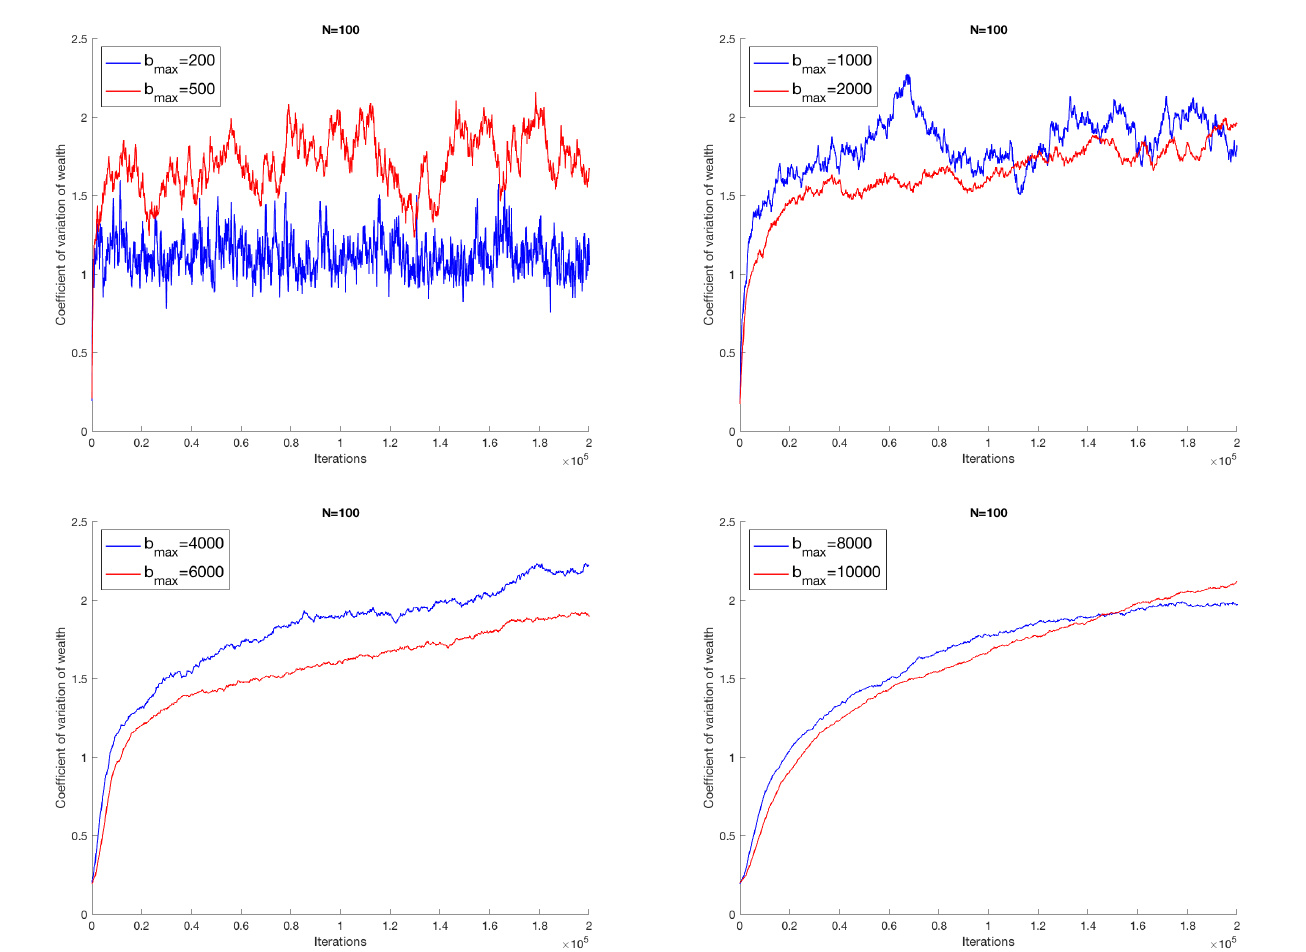
Figure 2. Plot of the coefficient of variation of the amount of money of the economic agents as transactions go on for N = 100 and b max = 200,500 ( top left) , b max = 1000,2000 ( top right ), b max = 4000,6000 ( bottom left ), b max = 8000, 10,000 ( bottom right